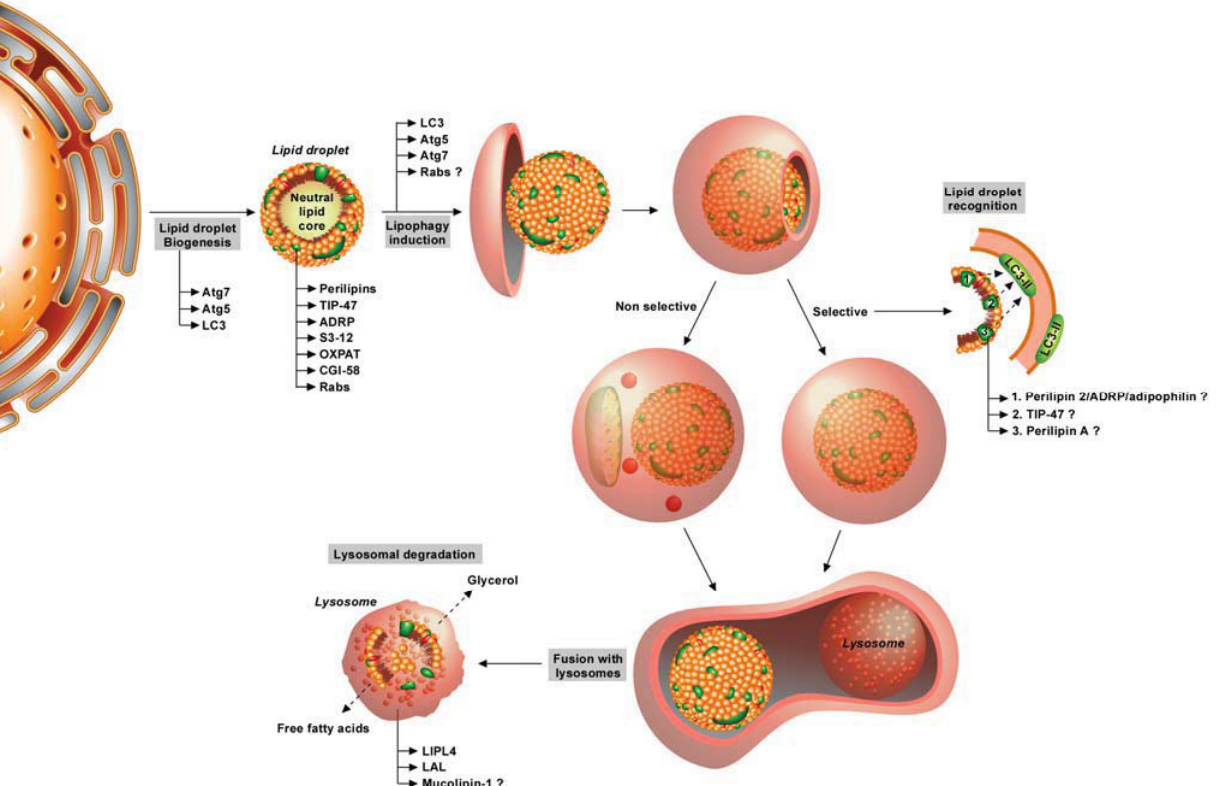
Figure 2. Mechanisms involved in